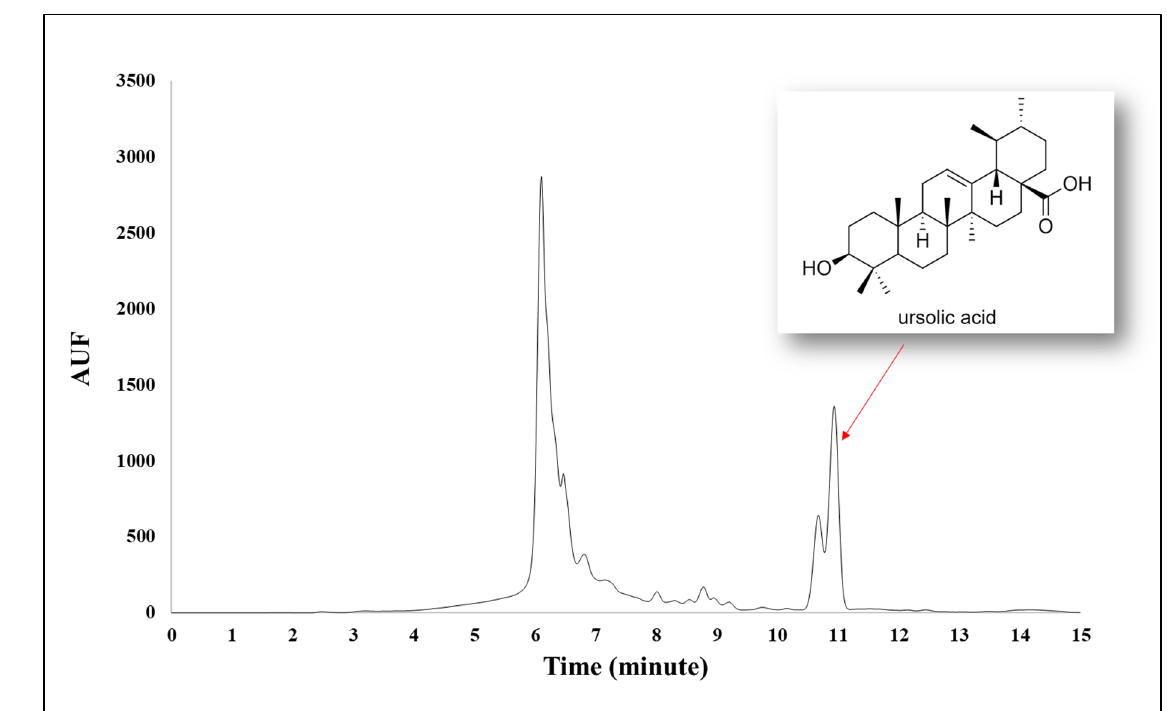
Figure 1. HPLC chromatogram of N. racemosa methanolic extract.